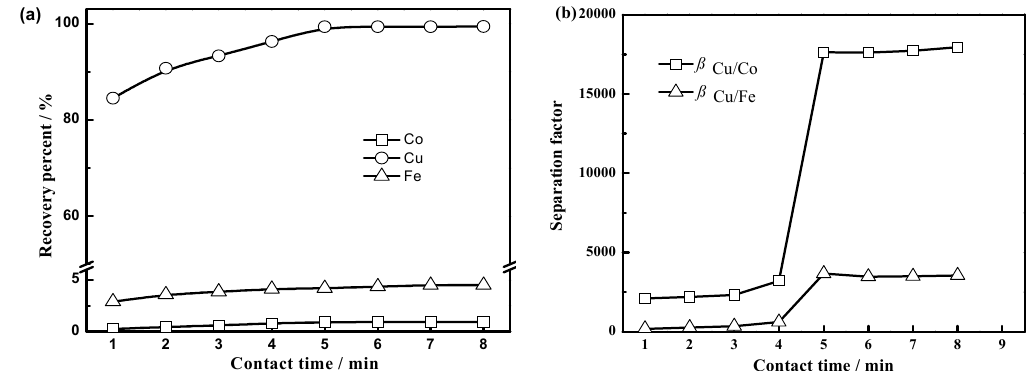
Figure 5. Effect of contact time on the recoveries of copper, cobalt, and iron ( a ) and separation factor ( b ) (A/O phase ratio = 1/1, pH =1.25, LIX 984N concentration =25% ( v / v ), temperature = 25 °C).